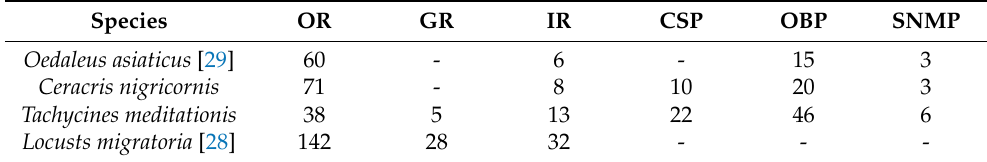
Figure 4. A maximum-likelihood phylogenetic tree of the OR gene family. Different colours represent different species of Orthoptera. The tree is rooted with the ORCO gene in Locusta migratoria . Table 2. The number of chemosensory genes of four orthoptera